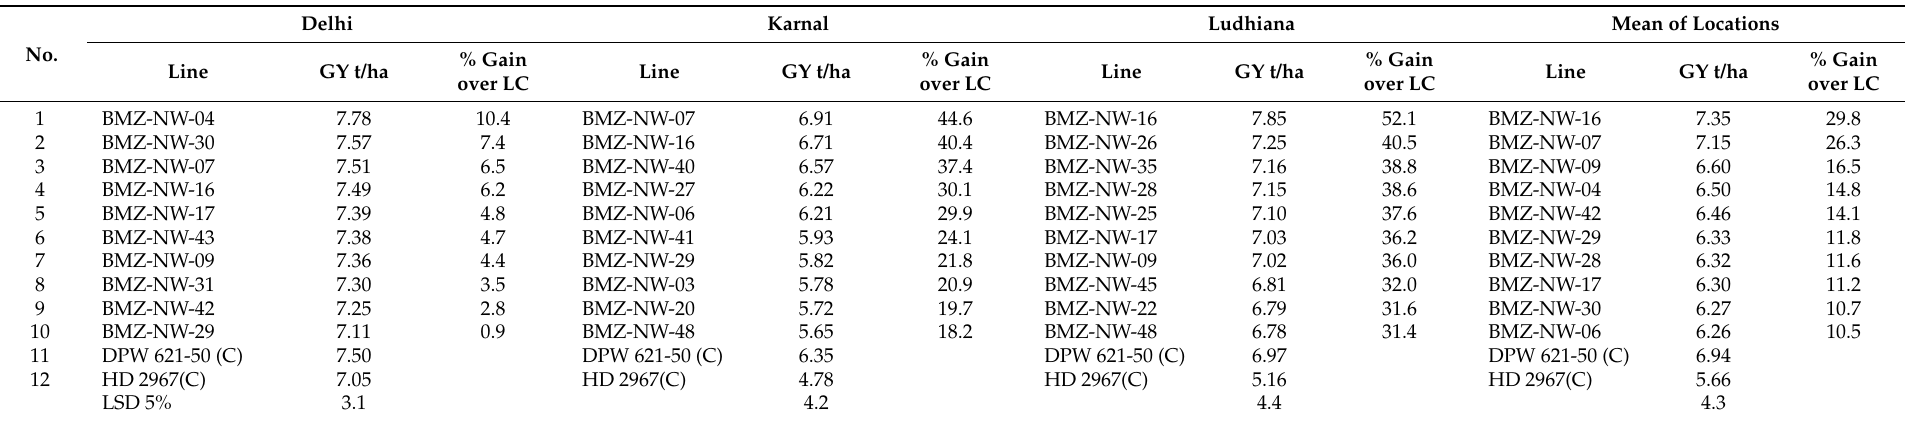
Table 4. Performance of genotypes for grain yield under early sowing in 2013–2014 in three locations of the North West Plains Zone of